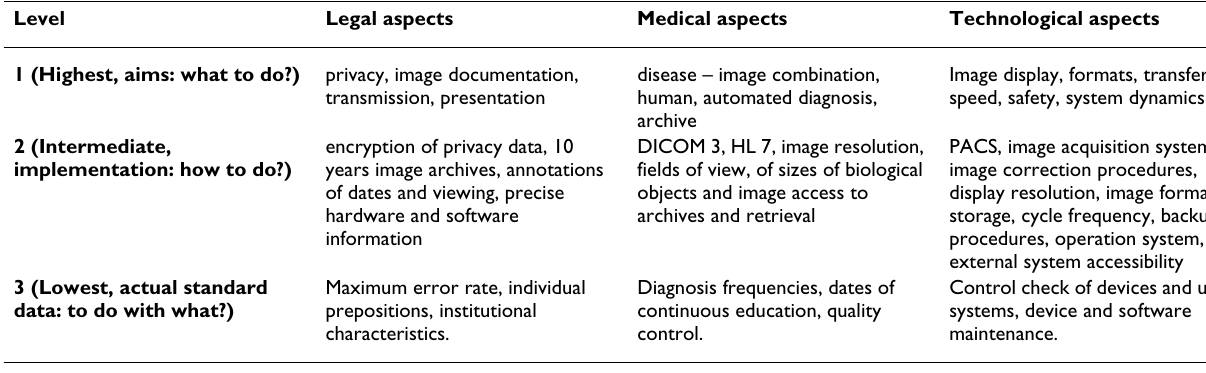
Table 1: Proposed levels of standards in tissue-based diagnosis